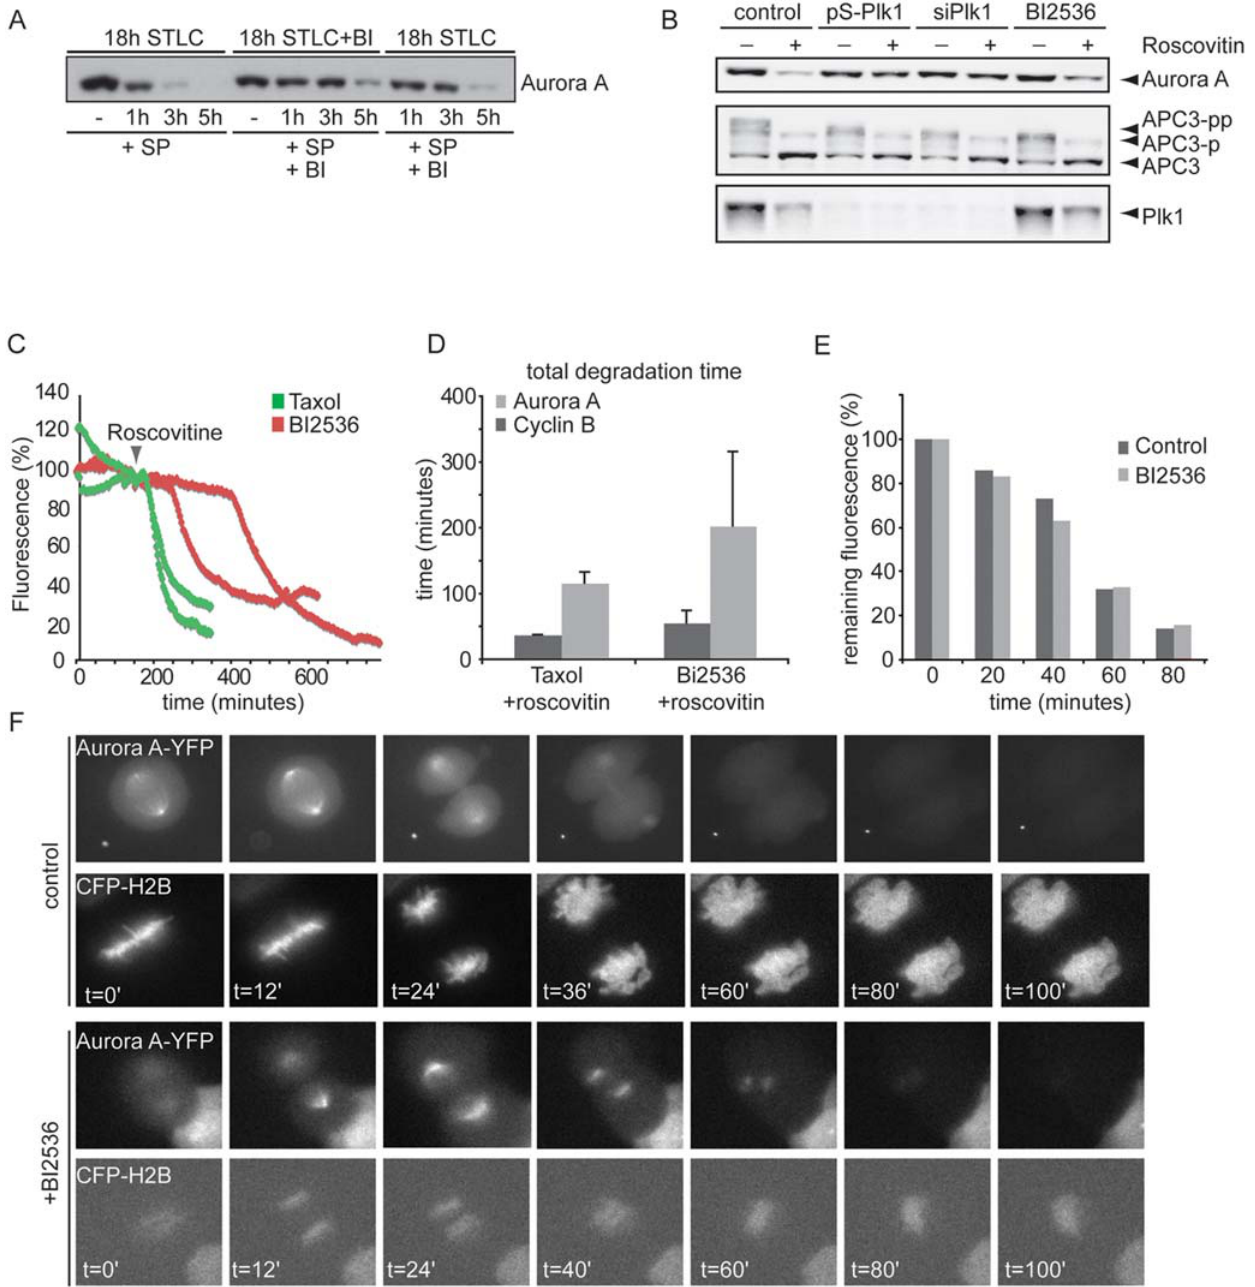
Figure 4. Plk1 activity is required to control Aurora A levels during mitotic exit. A. Cells were synchronized by treatment with 20 m M STLC for 18 h in the presence (BI) or absence of 20 nM BI 2536. Mitotic cells were then harvested by mitotic shake-off. Cells were replated in medium with STLC, BI2536 and immediately induced to exit from mitosis by addition of the Mps1 inhibitor SP600125, either alone (lanes 1–4) or in combination with 20 nM BI 2536 (lanes 5–8). Addition of BI2536 after release of the spindle checkpoint was insufficient to stabilize Aurora A to the same extent (Fig 4A, lane 9–12). At the indicated time-points samples were prepared in sample buffer and analyzed on Western blots with the indicated antibodies. B. U2OS cells were co-transfected with 1 m g pBabepuro vector and either 10 m g pS or pS-Plk1 vectors (and selected) or tranfected with a si-RNAi pool targeting Plk1. Cell were thymidine released and subsequently arrested in mitosis by adding Nocodazole to pS transfected cells, BI2536 to untreated cells, or intrinsically by Plk1-RNAi. Mitotic cells were collected by mitotic shake off. Half of the mitotic cells were replated in the presence of Roscovitin to force cells into G1 (lanes with + ), the other half of the mitotic cells were also replated but kept in mitosis (pS mitotic cells with nocodazole, pS-Plk1 mitotic cells intrinsically and untreated cells with BI 2536, lanes with 2 ). Cells were collected after 1 hour, lysed and protein levels were measured. Whole cell extracts were probed for APC3, Aurora A and Plk1. C, D U2OS cells were transfected with 0.1 m g Aurora A-YFP A and 0.1 m g Cyclin B1-Cherry. Following release form a thymidine block cells were incubated with taxol or BI2536. Roscovitin was added to induce mitotic exit and fluorescence images were obtained at indicated timepoints. In Plk1-depleted cells, onset of Aurora A destruction was first delayed and slow when mitotic exit was visible. D. Averages and standard deviations of total degradation times for Cyclin B and Aurora A were plotted (12 cells). E. U2OS cells transfected with Aurora A-YFP A and H2B-CFP were treated with or without BI2536 after chromosome alignment was completed. YFP levels during mitotic progression were measured. F. Graphs show quantification of representative images of YFP fluorescence from metaphase to the next G1 in cells treated with or without BI2536.